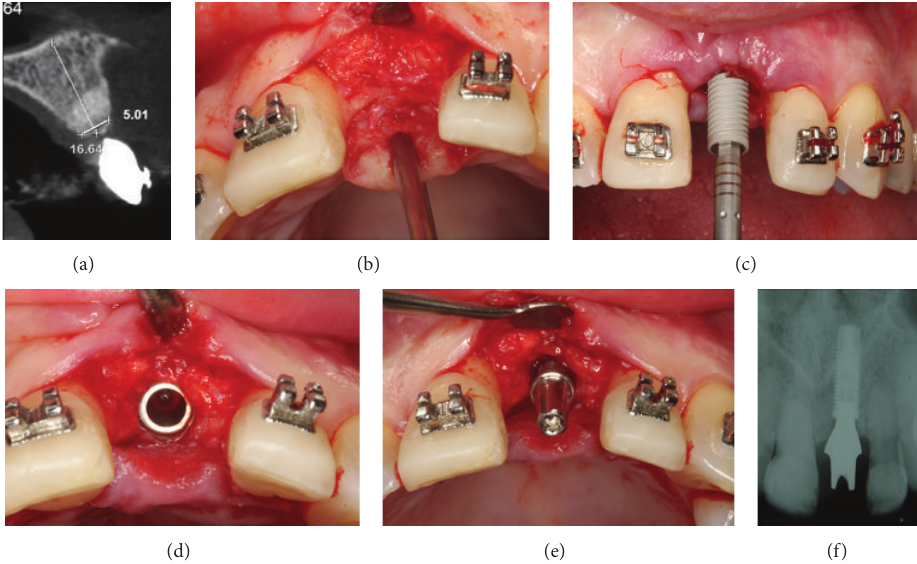
Figure 8: Implant placement after orthodontic movement showing bone volume augmented allowing implant placement in an ideal 3- dimensional position and immediate installation of a provisional